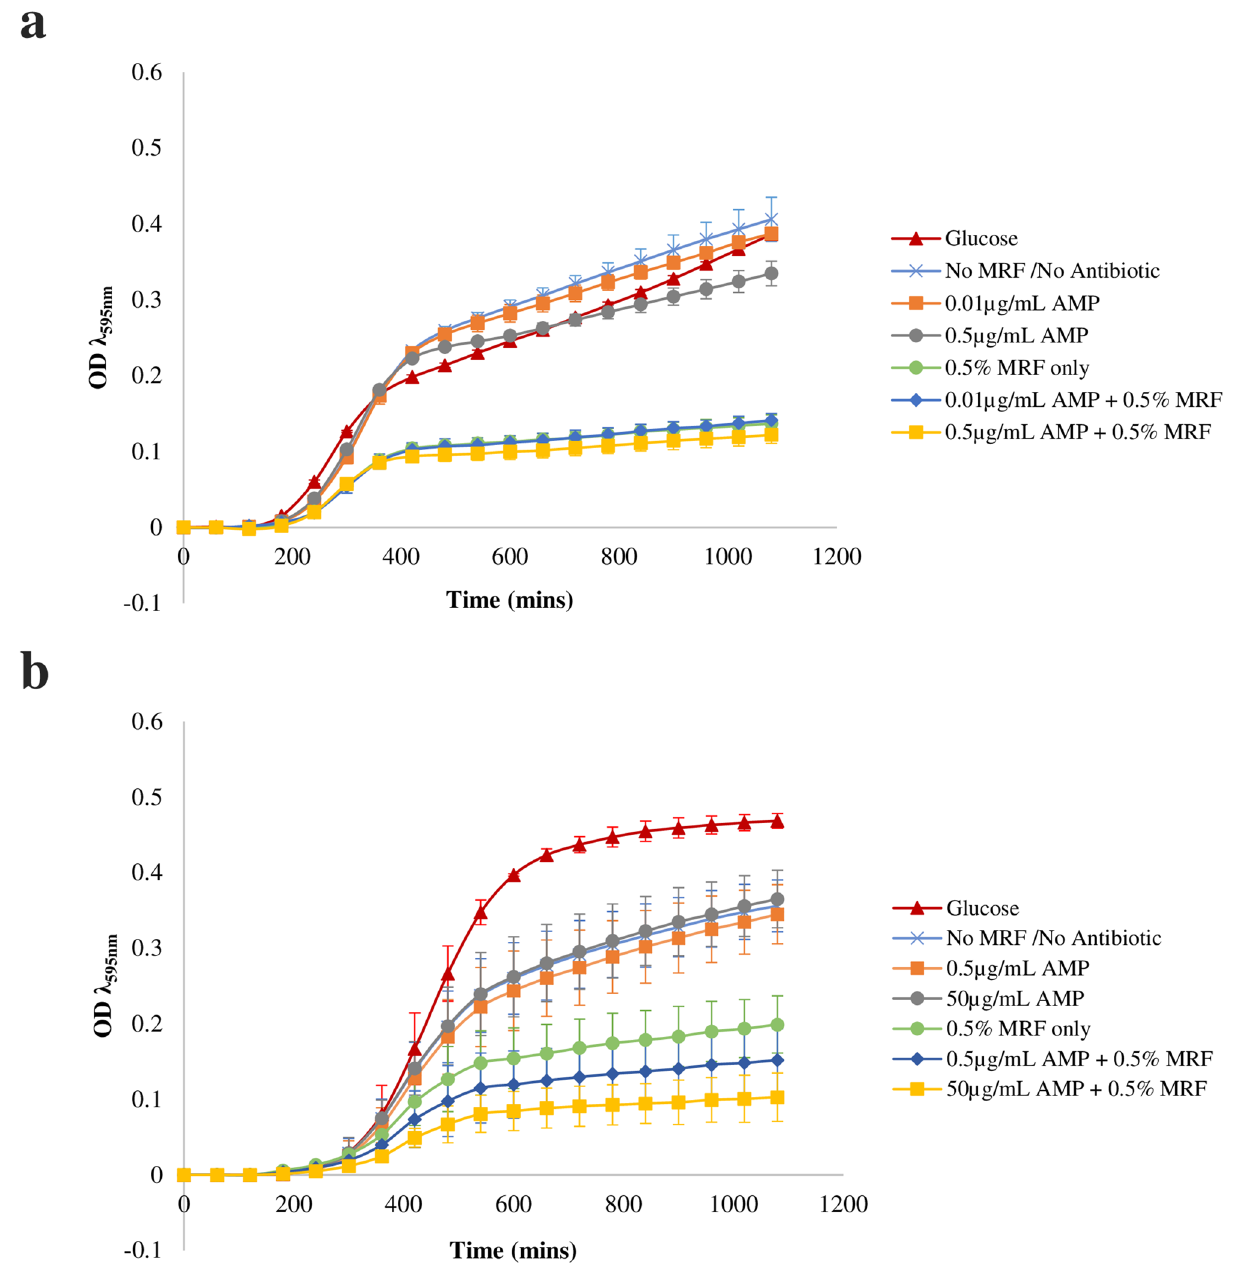
Figure 1. MRF modulates growth of susceptible and resistant E. coli . Growth curves of (a) antibiotic susceptible E. coli and (b) antibiotic resistant E. coli supplemented and not supplemented with MRF (0.5%), in the presence and absence of ampicillin (AMP). Each value was expressed using mean of triplicate values for each biological replicate (n = 3), standard deviation is represented by error change in OCR over time between antibiotic susceptible and resistant E. coli when supplemented and not sup- plemented with MRF (refer also to Fig S2 online). Supplementation of MRF lead to an acceleration of basal cellular metabolism. When MRF is supplemented into the media, oxygen is consumed at a faster capacity by the cells leading to a subsequent earlier drop in OCR compared to cells not supplemented with MRF. The resistant strain which maintains OCR > 160 min when treated with antibiotics begins to decline ~ 105 min with MRF supplementation, reverting OCR to a similar state to that of the sensitive strain, mimicking OCR of an antibiotic susceptible species (Fig. 3b). Having established a direct link between antibiotic susceptibility and MRF with respect to cellular metabo- lism and having shown that MRF supplementation resulted in significant collateral sensitivity of the resistant organism via growth modulation ( p ≤ 0.05) (Figs. 1b and 2d), we explored the metabolic perturbations of MRF and ampicillin in combination. When susceptible and resistant E. coli were treated with ampicillin and MRF in